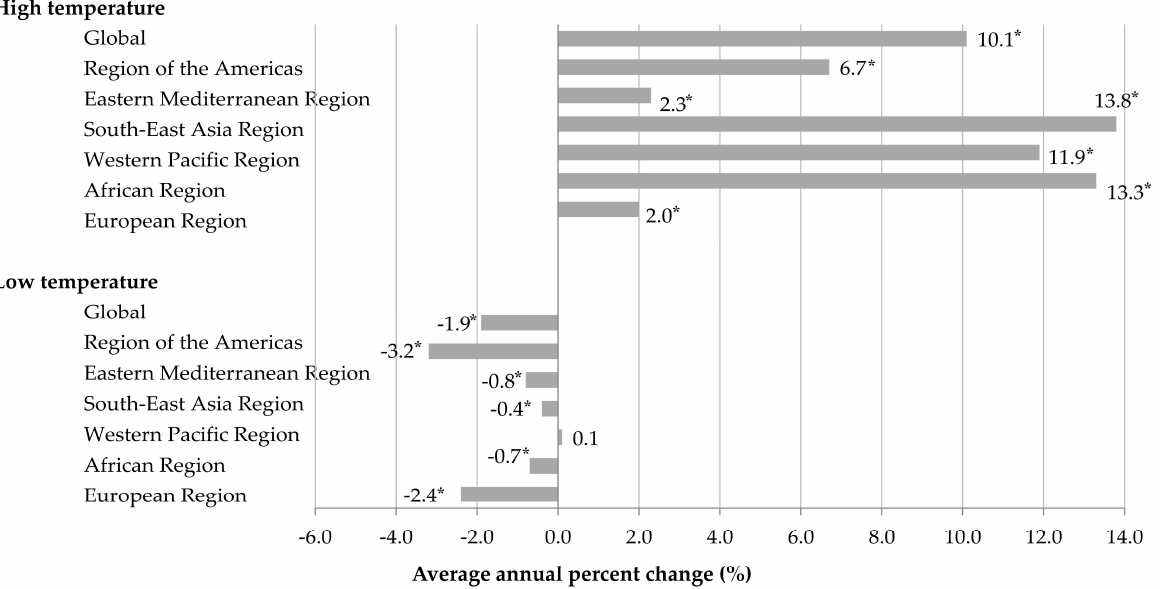
Figure 4. Global and regional trends of ischemic heart disease mortality rates (per 100,000) attributed to non-optimal temperature, in both sexes together, 1990–2019; a joinpoint regression analysis. * statistically significant, p < 0.05.